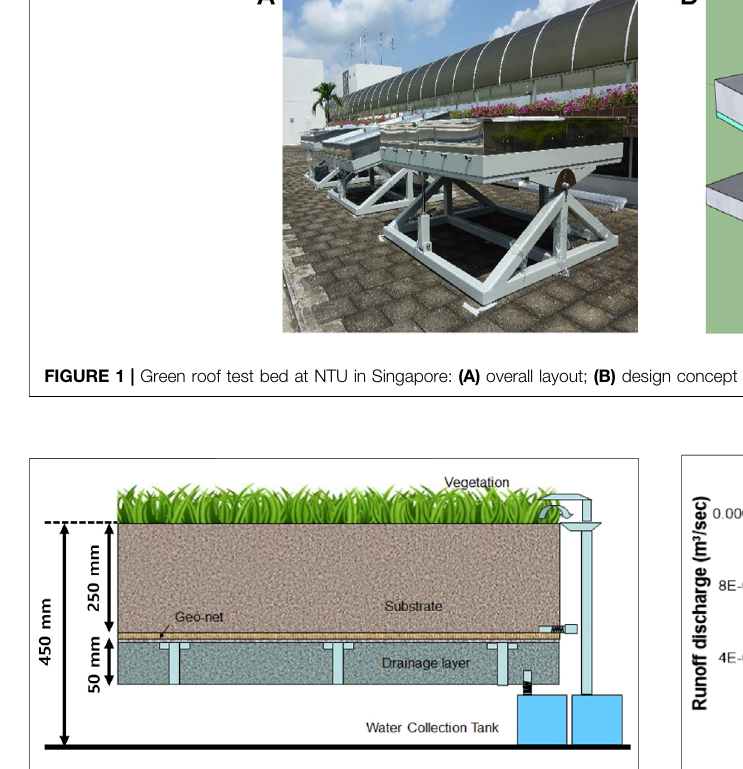
FIGURE 2 | Structural components of the green roofs at NTU (Qin et al., 2012).